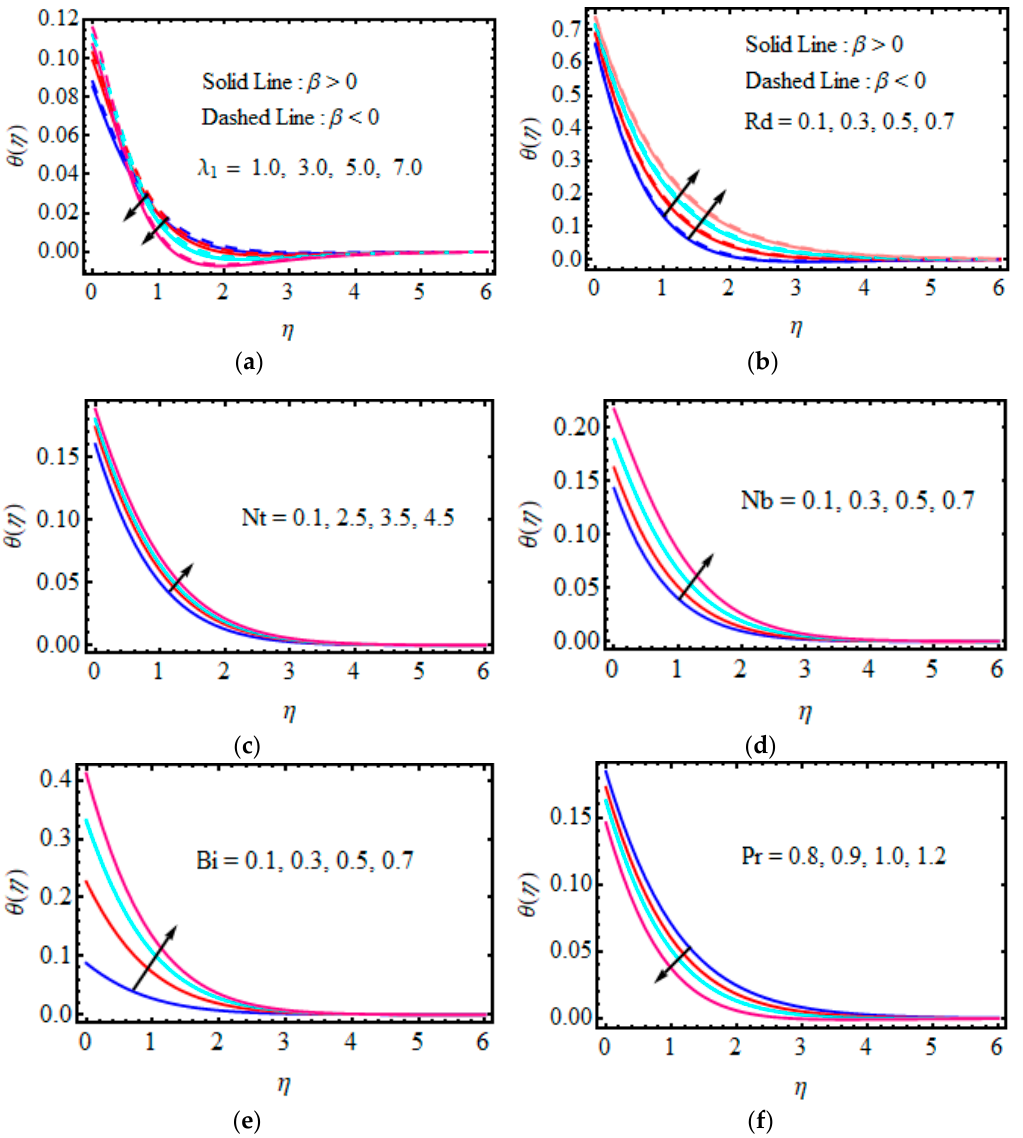
Figure 3. ( a – d ). The impact of the numerous variables 𝑜𝑓 𝑓 (cid:4593) (cid:4666)𝜂(cid:4667) : ( a ) 𝛿 , ( b ) 𝑅𝑒 (cid:3082) , ( c ) 𝛽 and ( d ) Z.